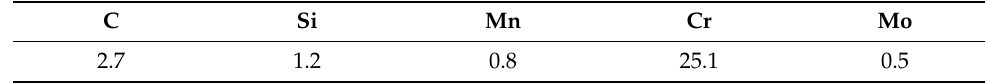
Table 1. Chemical Composition (% in weight).